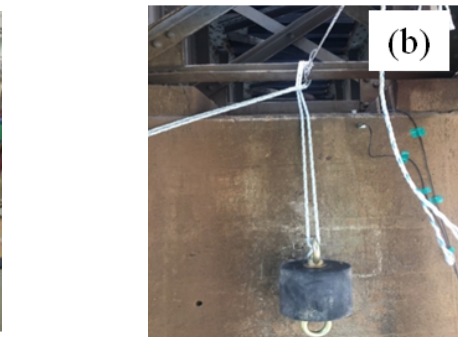
Figure 3. Equipment used in the experiment. ( a ) Data logger and ( b ) weight.